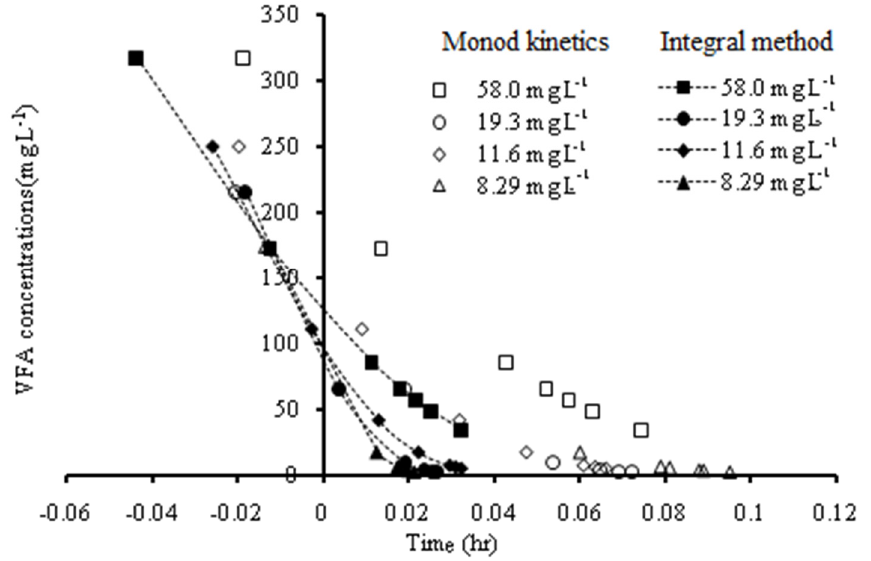
Figure 5. Comparison of the results of the calculation method with the experimental data for VFA degradation at different feed flow rates. Symbols refer to the Monod kinetic model, and the dash line refers to the integral method. Table 4. Theil’s inequality coefficient (TIC) values for the Monod and integral methods.